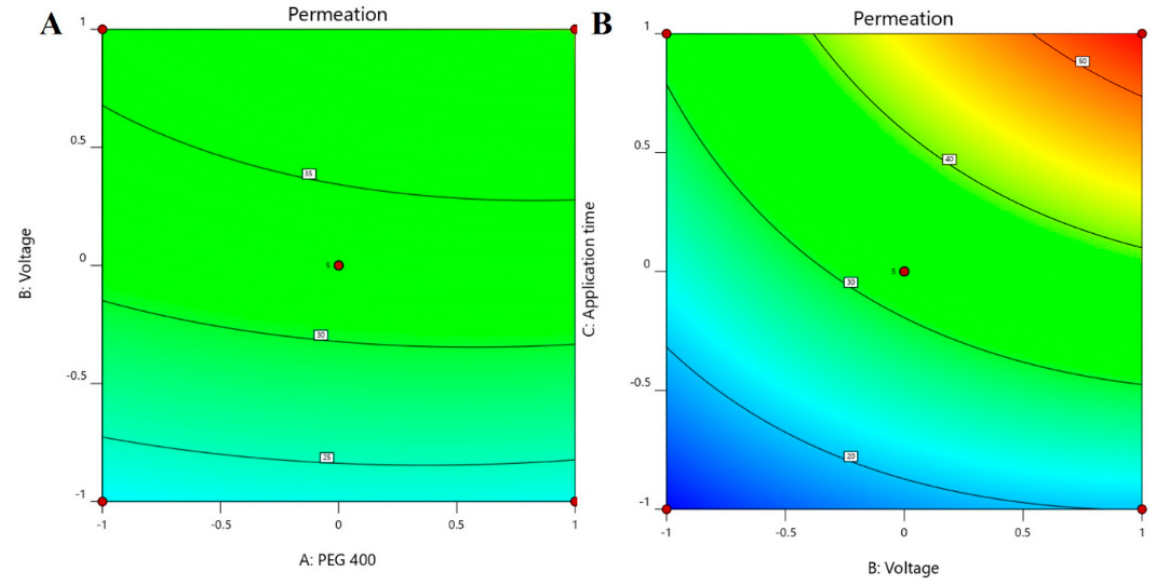
Figure 4. Contour plot response displaying the effect of independent variables on the permeation of drug ( A ) voltage versus PEG 400 and ( B ) application time versus voltage.